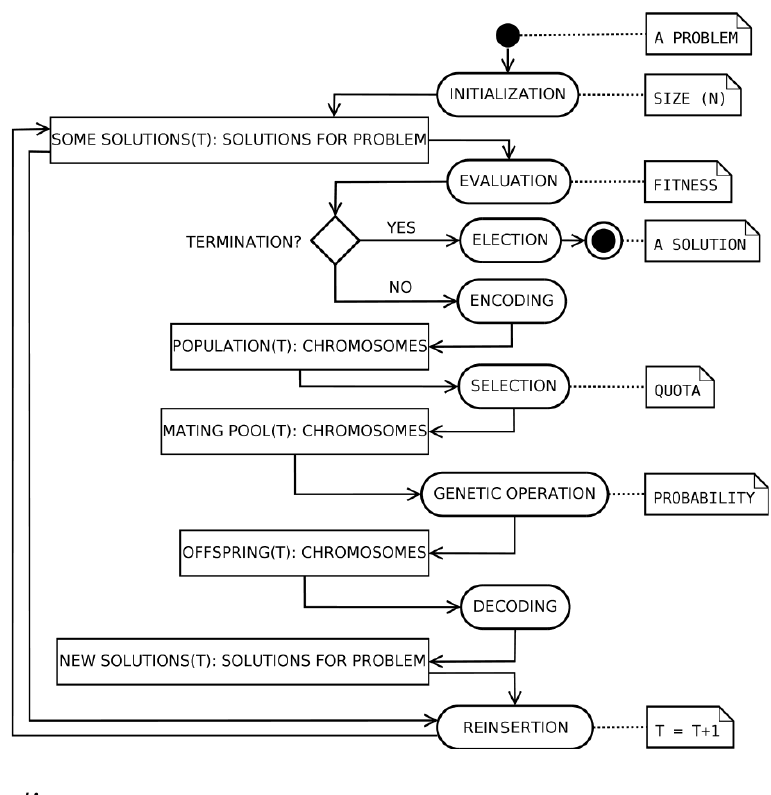
Figure 8. The general structure of the